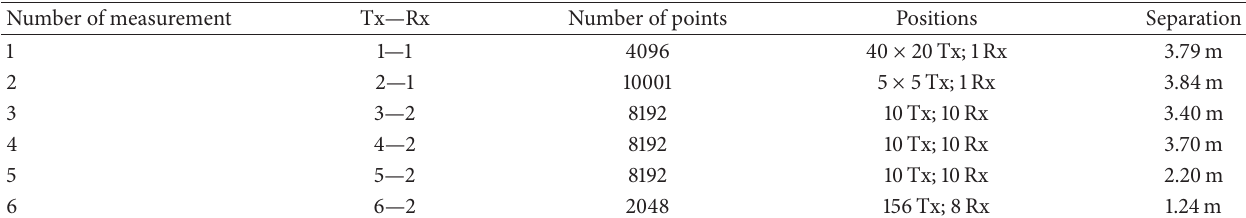
Table 1: Main parameters in each measurement experiment in the 57–66 GHz band.